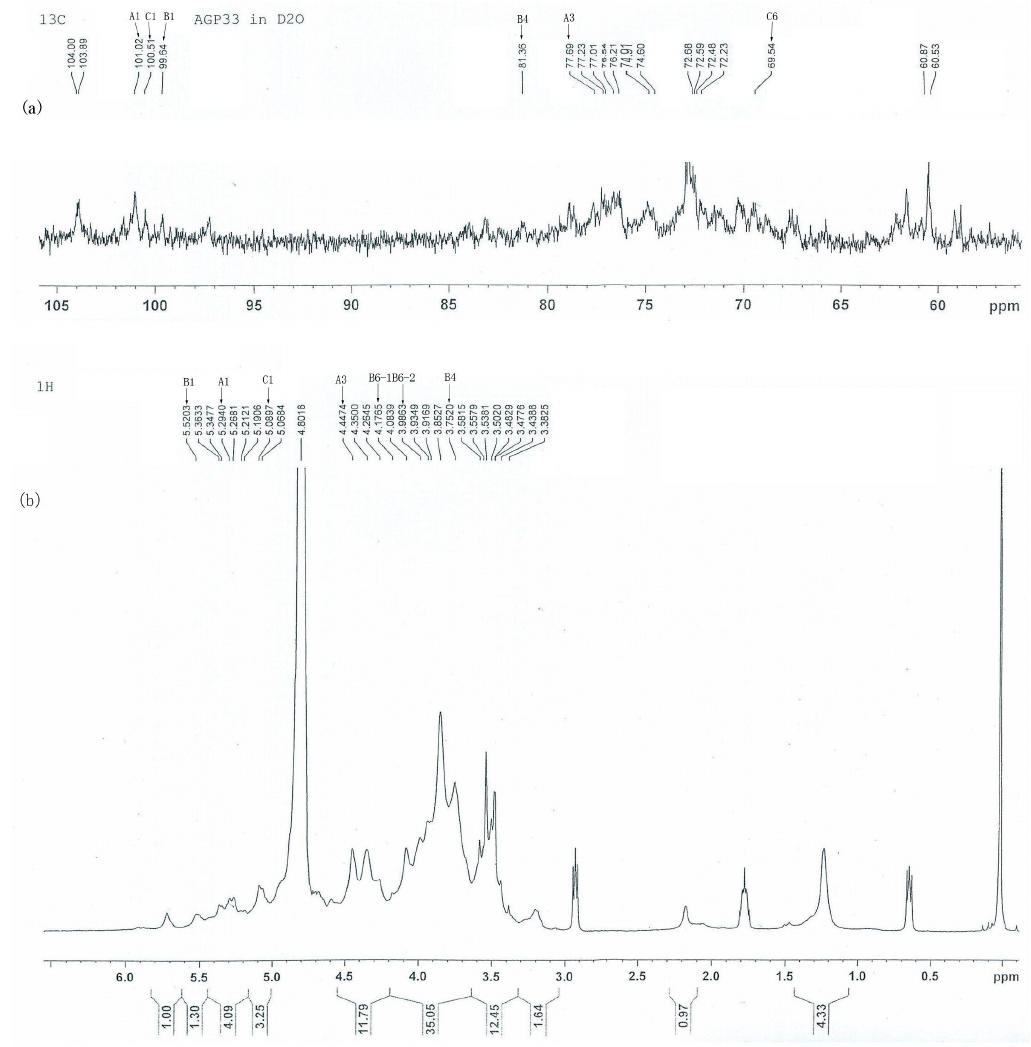
Figure 2. 13 C-NMR ( a ) and 1 H-NMR ( b ) spectrum of AGP33. Residues A: 1,3- D -Glc p , Residues B: 1,4- D -Gal p and Residues C: 1,6- D -Glc p .